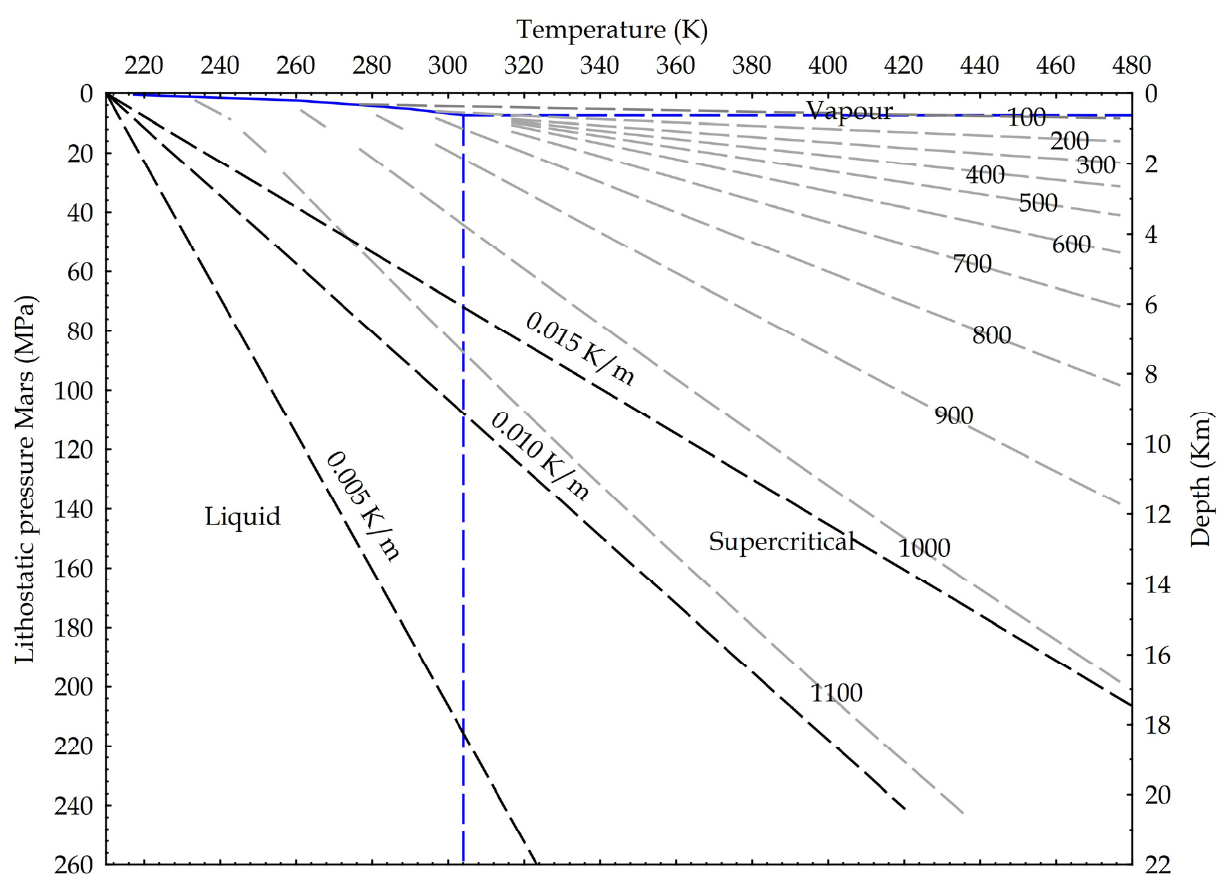
Figure 10. Martian crustal profile and CO 2 state diagram. Three possible thermal gradients from 0.005 K/m to 0.015 K/m; lithostatic pressure calculated on basalts (3100 kg/m 3 ) and Martian gravity acceleration (3.711 m/s 2 ). Density isolines are indicated, calculated from NIST data.